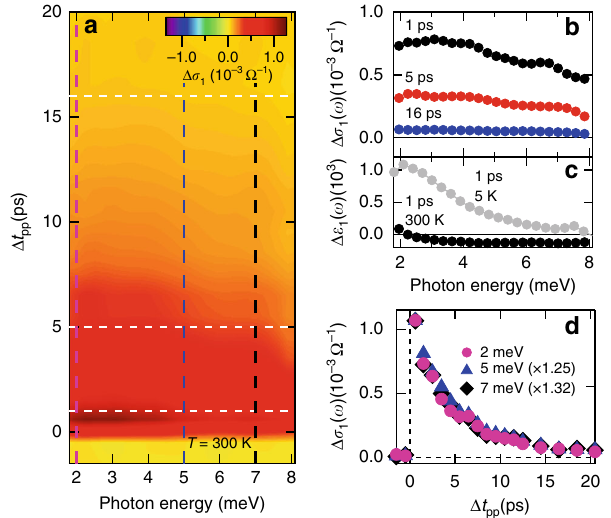
Fig. 3 Frequency-independent dynamics of THz spectra at high temperature. a Pump-induced THz spectra of Δ σ 1 ( ω ) after 248 meV (5 μ m) photoexcitation with fl uence 12 μ J cm − 2 at T = 300 K as a function of pump-probe delay Δ t pp . b THz conductivity Δ σ 1 ( ω ) from three cut positions from a , at Δ t pp = 1, 5, 16 ps, as indicated by the white-dashed lines. c THz spectra of Δ ε 1 ( ω ) at Δ t pp = 1 ps for 5 K (gray dots) and 300 K (black dots), the amplitude of which is much smaller at high temperature, opposite to low temperature ones in Fig. 2c, d. d The comparison of THz conductivity Δ σ ω ) at three frequencies: 2, 5, and 7 meV, as a function of Δ t 1 ( to match amplitude), from three frequency-cut positions from a as indicated by magenta, blue, and black dots, respectively. The frequency-